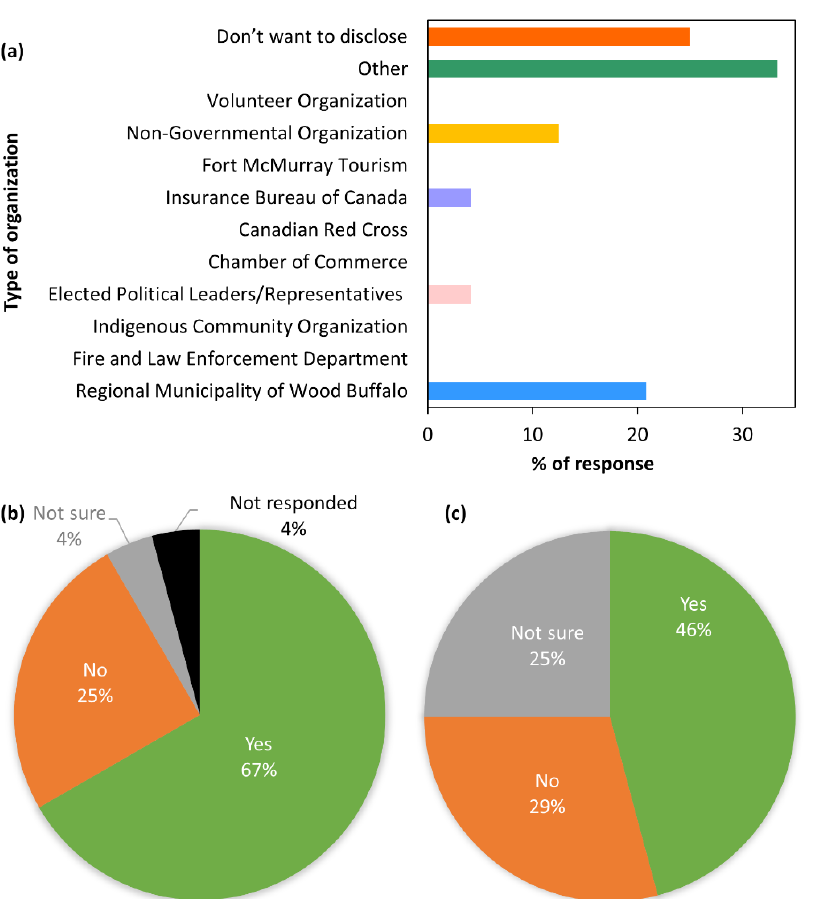
Figure 2. Types of participants’ organizations ( a ), and whether their organization have: collabo- rated/cooperated/ coordinated with others ( b ) and received any further training/capacity building programs in wildland fire-induced risk management ( c ) during and after the 2016 HRF event.